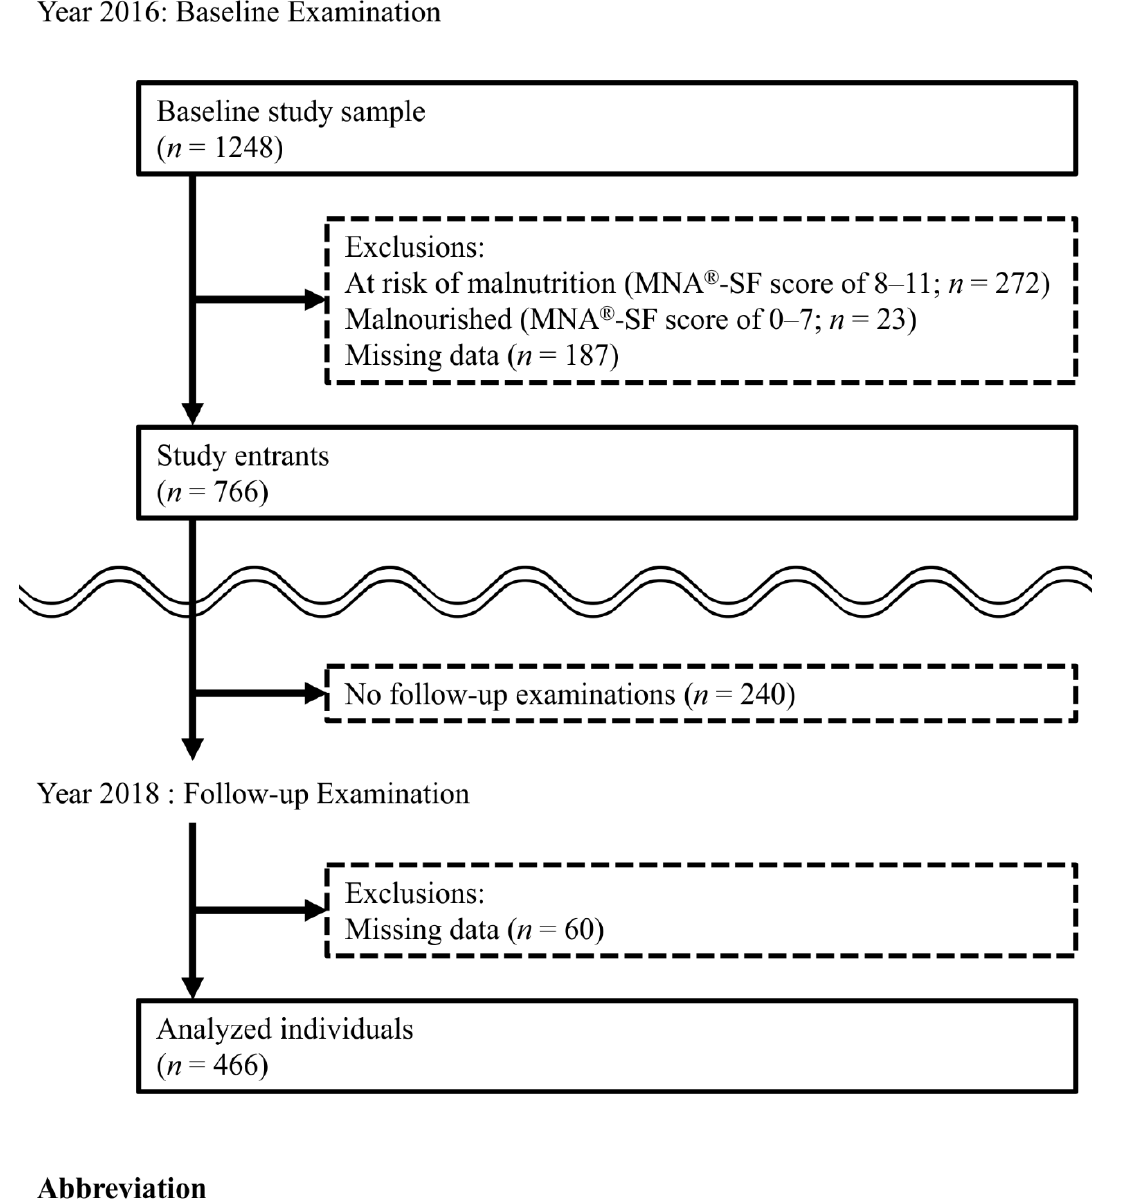
Figure 1. Flow diagram of our study.